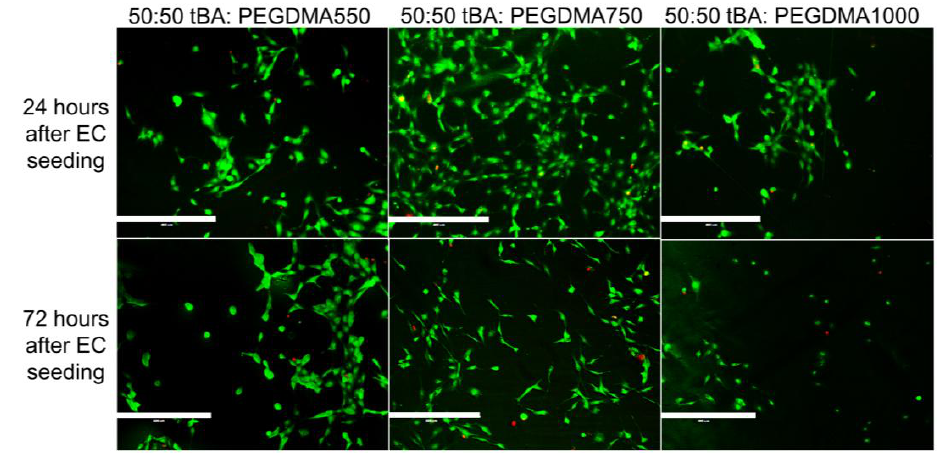
Figure 6. Live-Dead Analysis of SMP formulations with equal weight percent monomer (tBA) and crosslinker (PEGDMA). There are endothelial cells present on the surface of all samples regardless of crosslinker length, but there is some variability based on the crosslinker used in the sample. Specifically, both PEGDMA550 and PEGDMA750 samples seem to support more HUVEC attachment as compared to the PEGDMA1000 sample. Scale bar = 400 µm.